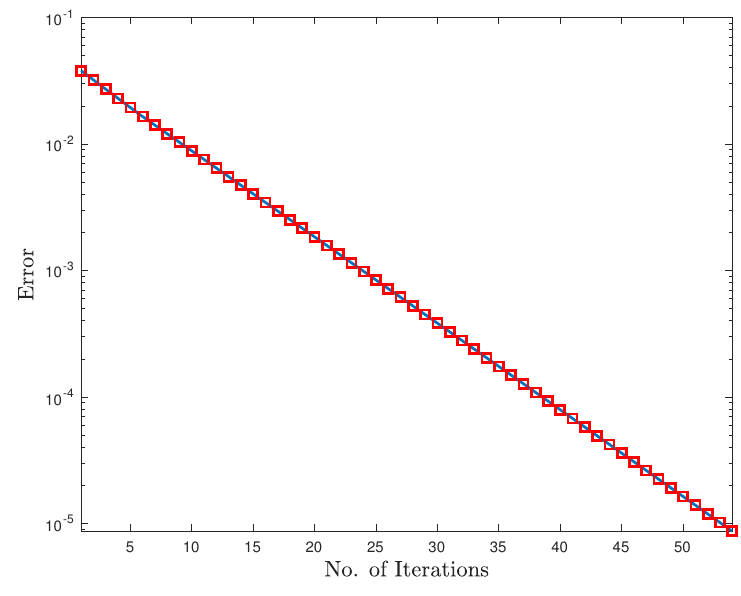
Figure 1. Convergence